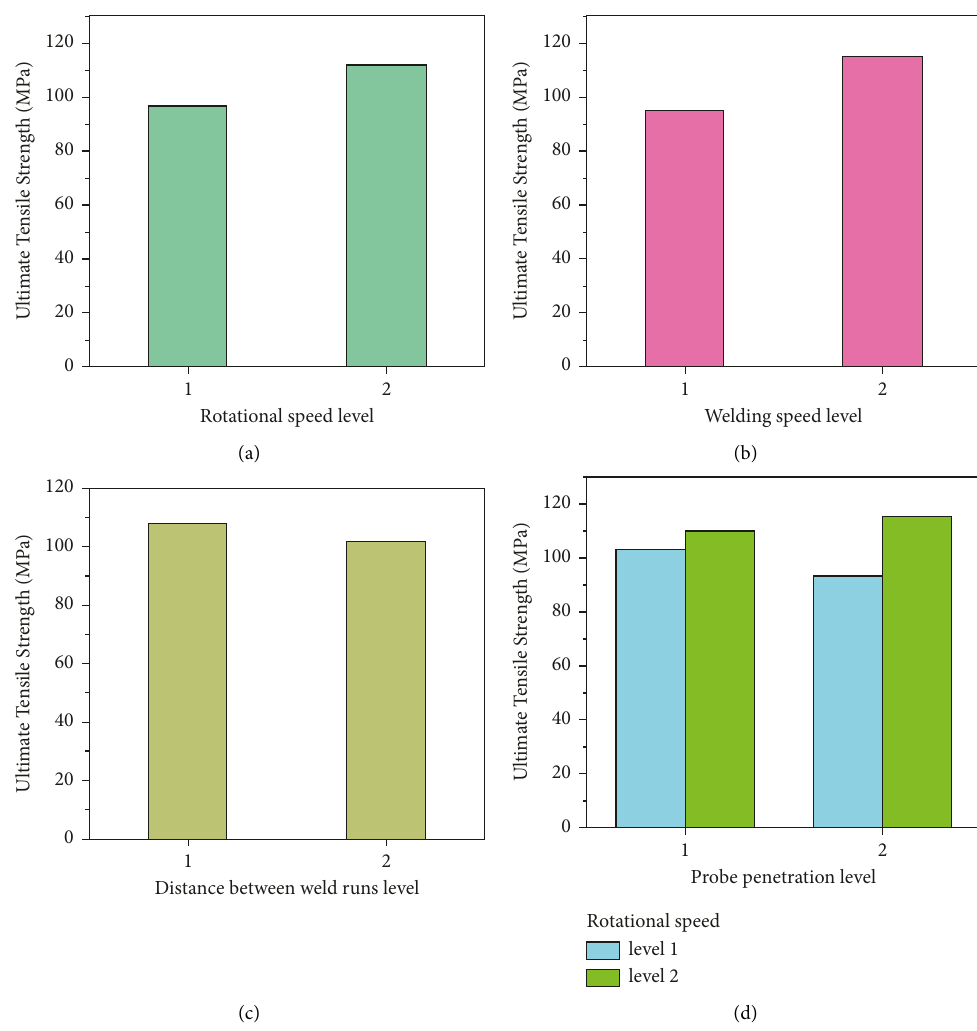
Figure 5: (a-d) Lap joint trend analysis of the mean main effect of the different